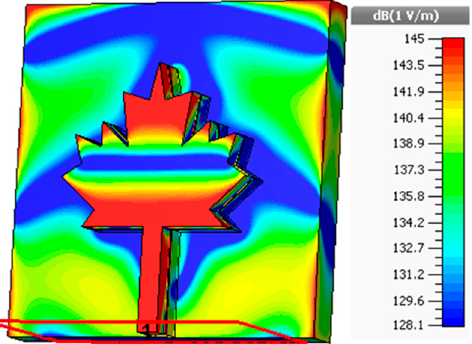
Figure 9. Three-dimensional far-field gain pattern for the designed antenna at ( a ) 193 THz ( b ) 229 THz ( c ) 353 THz and ( d ) 393 THz